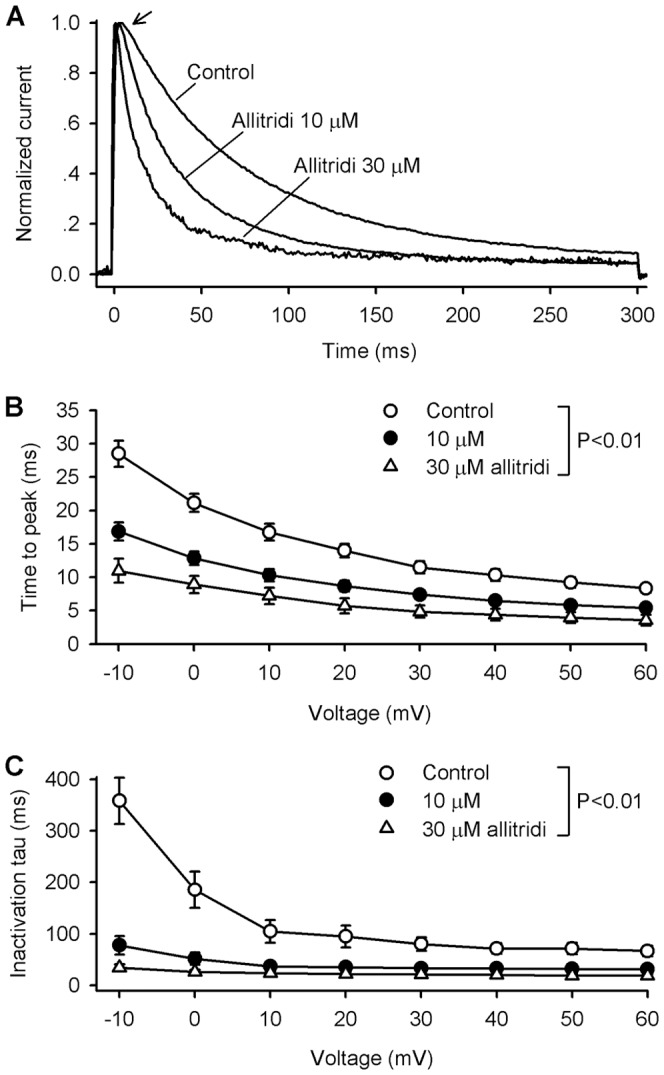
Open channel blockade of hKv4.3 by allitridi.
A. Normalized current (+60 mV) in a representative cell before (control) and after 10 and 30 µM allitridi. The arrow indicates the changes of the time to peak of the current activation. B. Mean values of the time to peak of the current activation at −10 to +60 mV before and after application of 10 and 30 µM allitridi (n = 11 experiments, P<0.01 vs. control). C. Mean values of time constant of hKv4.3 current inactivation at −10 to +60 mV before and after application of 10 and 30 µM allitridi (n = 11 experiments, P<0.01 vs. control).